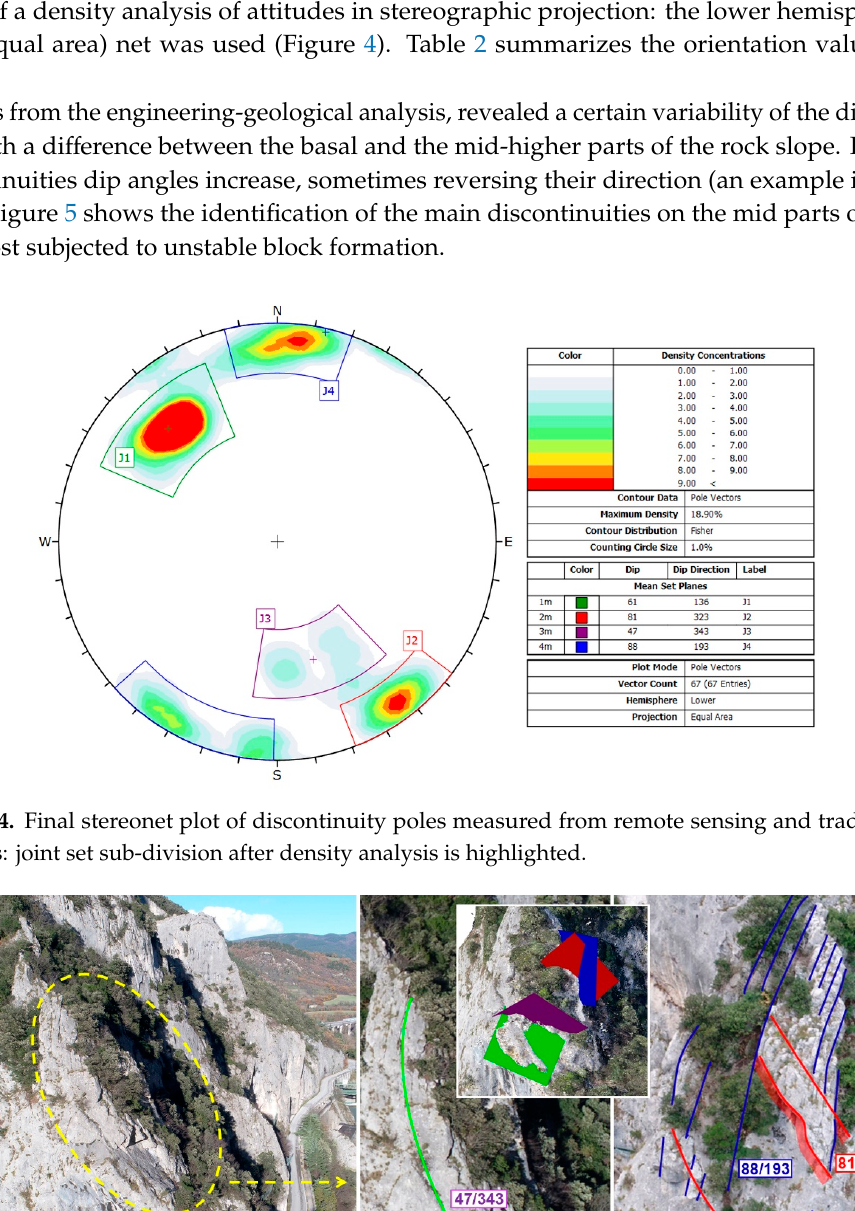
Figure 5. Examples of the main discontinuity sets identified on the mid-part of the rock slope. Table 2. Mean orientation values of discontinuity sets measured on the study